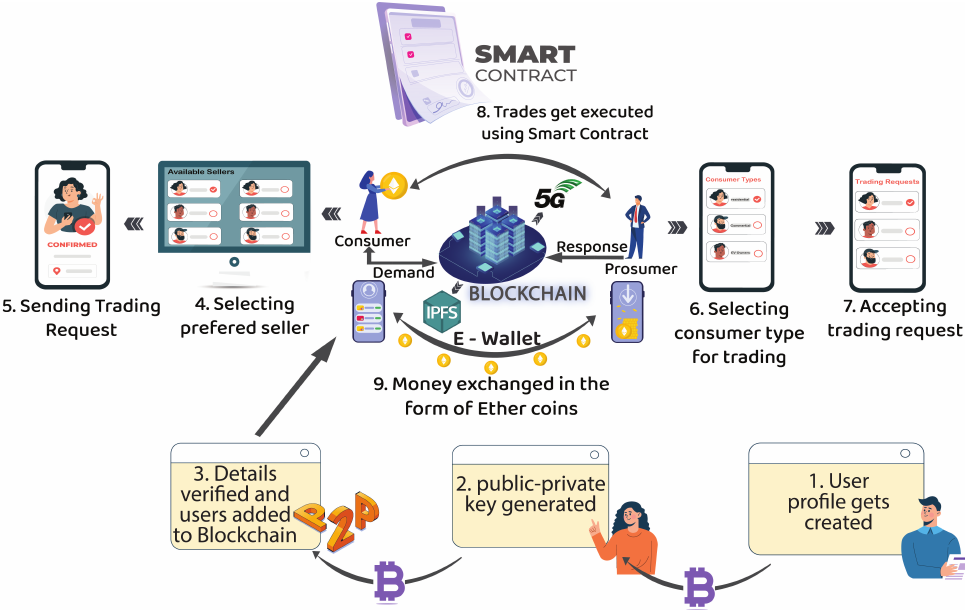
Figure 2. System model of the proposed DT-P2PET